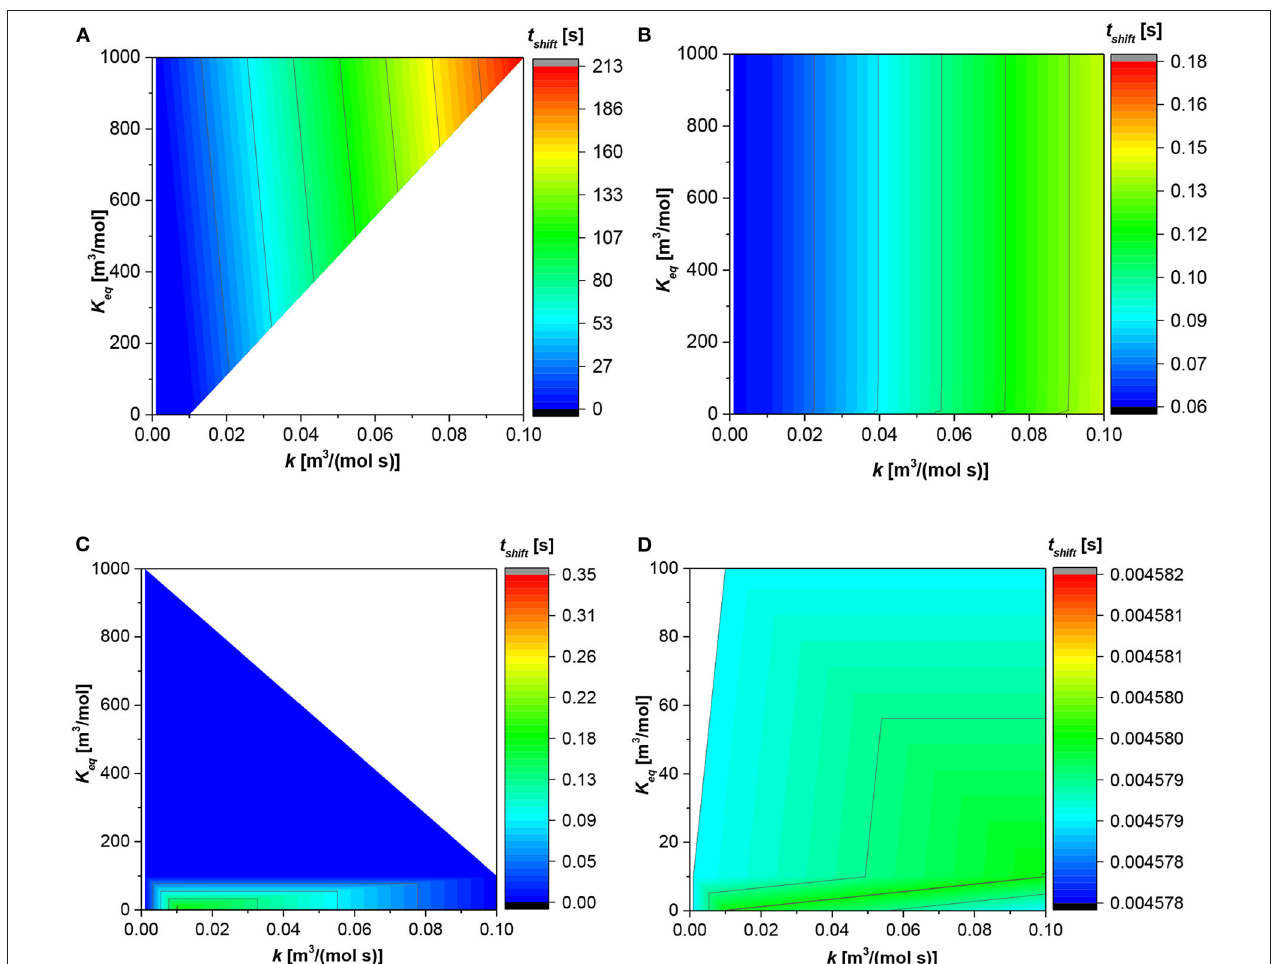
FIGURE 3 | Contour plot for the shift time ( t shift ) along the reaction and equilibrium constant. (A) First dimensionless number ( AD 1 ) = 1 × 10 − 3 [-]; (B) AD 1 = 1 × 10 − 2 [-]; (C) AD 1 = 1 × 10 − 1 [-]; (D) AD 1 = 1